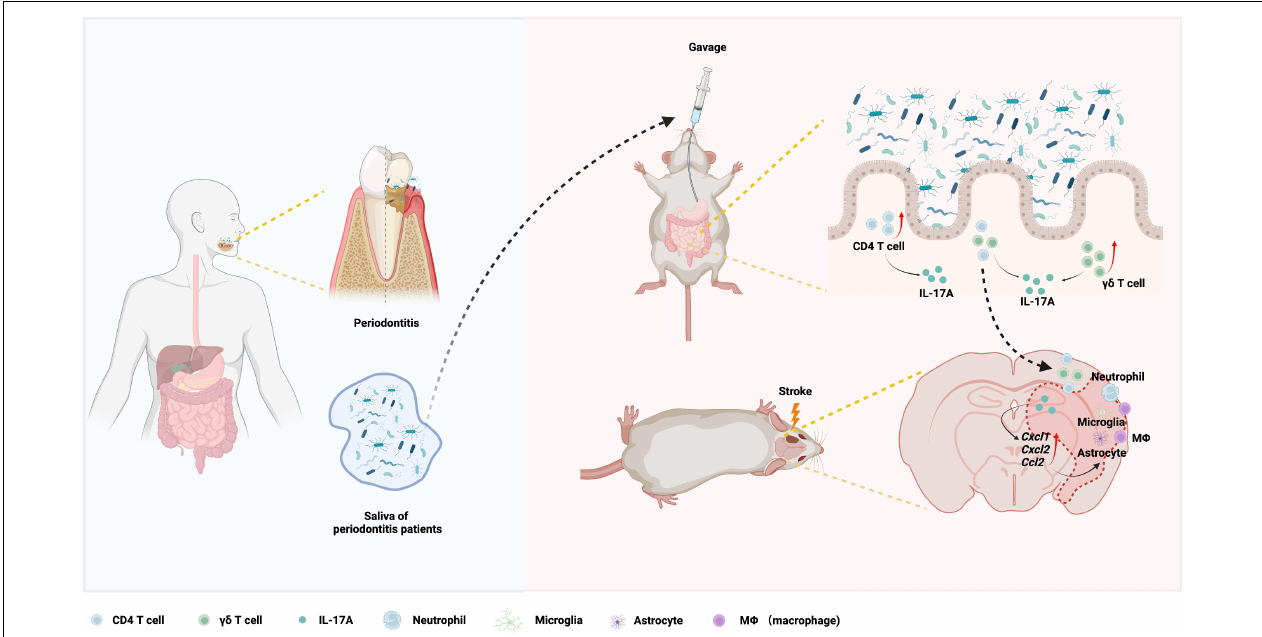
FIGURE 7 | Working model for the exacerbation of ischemic stroke by periodontitis salivary microbiota. Periodontitis salivary microbiota increases IL-17A-producing cells in the small intestine, which contain CD4 + T cells and TCR- γδ + T cells. Increased migration of IL-17A-producing cells from the gut to the brain elevates post-ischemic chemokines ( Cxcl1 , Cxcl2, and Ccl2 ) and ultimately infiltration and activation of immune cells (macrophages/microglia, astrocyte, and neutrophils) in ischemic brain, leading to exacerbated neuroinflammation and ischemic stroke